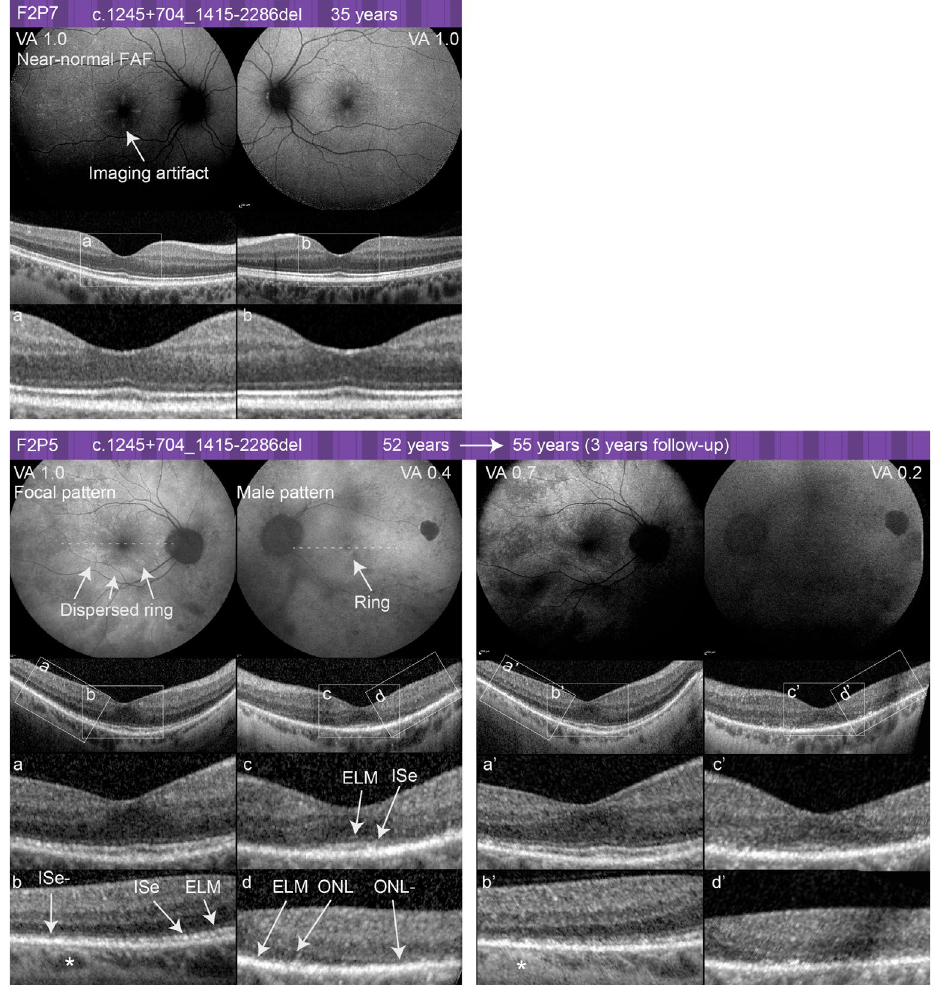
Figure 10. FAF and OCT of females from family 2. Dashed lines show the location of the OCT scans through the macula, and dashed boxes mark the OCT sections that are enlarged (marked with corresponding letters a – d and a’ – d’ in follow up). Follow-up images are shown for patient F2P5. * vessel.